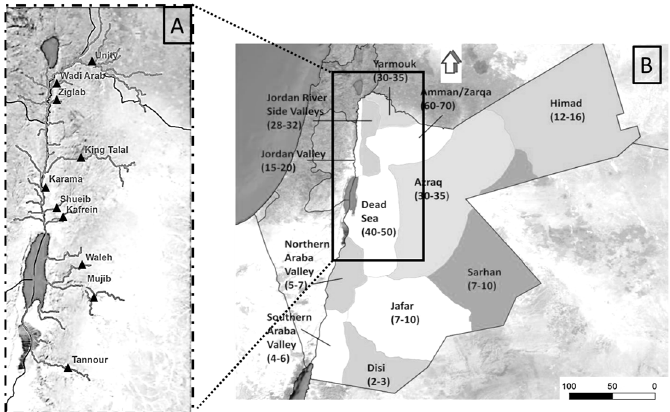
Figure 1. Summary of the Jordanian water system. ( A ) Surface water including dams, rivers, and streams. ( B ) Groundwater basins and their annual safe yield in millions of cubic meters